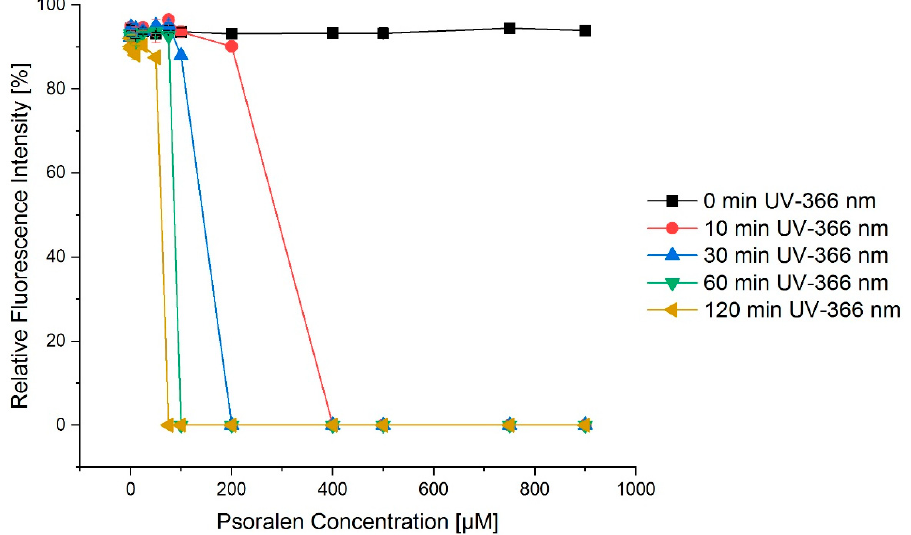
Figure 2. Exemplary concentration–effect relations for the combination of psoralen and varying irradiation times of UV-366 nm for the SC conformation. The longer the irradiation with UV-366 nm, the more intense the fractions of the open circular confirmation as a consequence of the SC conformation quickly dropping to zero. The error bars show the SEM.